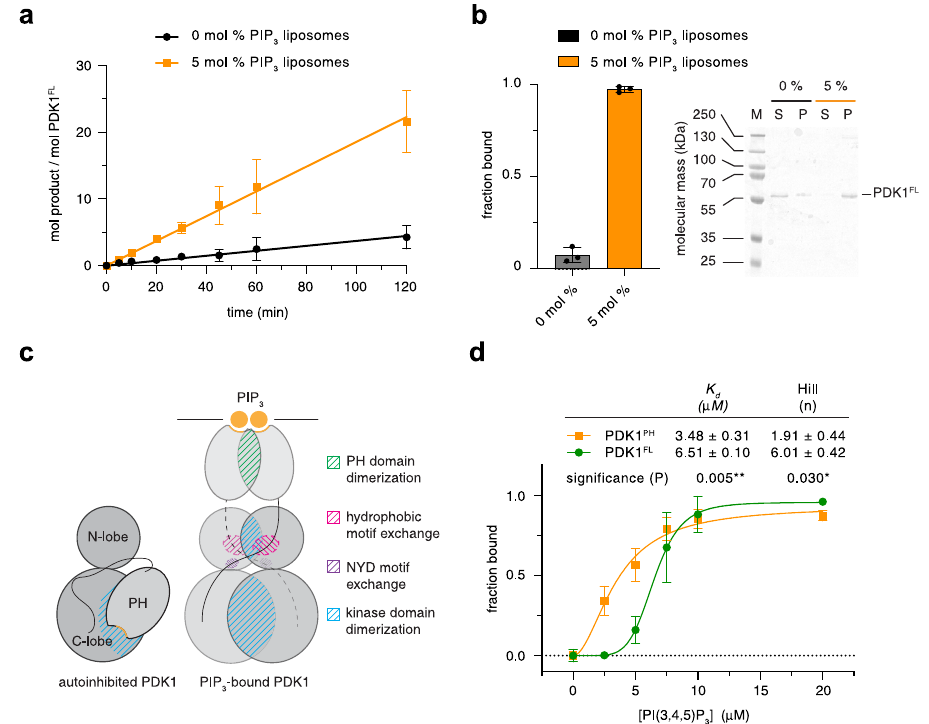
Fig. 5 PIP 3 drives cooperative, switch-like PDK1 activation. a Radiometric substrate (Crosstide) phosphorylation assay. Initial PDK1 reaction velocities in the presence of liposomes containing 0 mol % or 5 mol % PIP 3 were determined by linear regression of data points up to 120 min in which substrate consumption was no more than 2.5%. n = 3 biologically independent experiments. Data are presented as mean values± S.D. b Binding of PDK1 FL to liposomes containing 0 or 5 mol % PIP 3 under kinase assay reaction conditions. n = 3 biologically independent experiments. Data are presented as mean values ± S.D. c Schematic of the conformational changes predicted upon PIP 3 binding. d Binding of PDK1 FL and PDK1 PH to 0 – 2 mol % PIP 3 liposomes. n = 3 biologically independent experiments. Data are presented as mean values± S.D. Data were fi t with a Hill-Langmuir isotherm in which no parameters were constrained. The equilibrium dissociation constants derived from curve fi tting, together with the respective Hill coef fi cients, are reported in the table (inset). The differences in both Kd and n were determined to be signi fi cant by a two-tailed t -test ( P = 0.005 for the difference in Kd and P = 0.030 for the difference in n